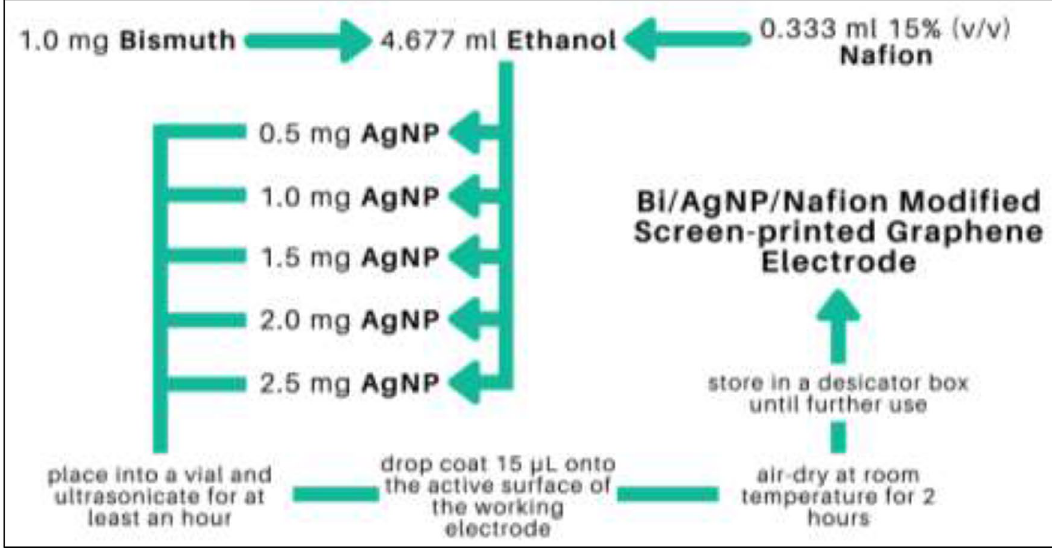
Figure 2. Schematic diagram for the modification of the